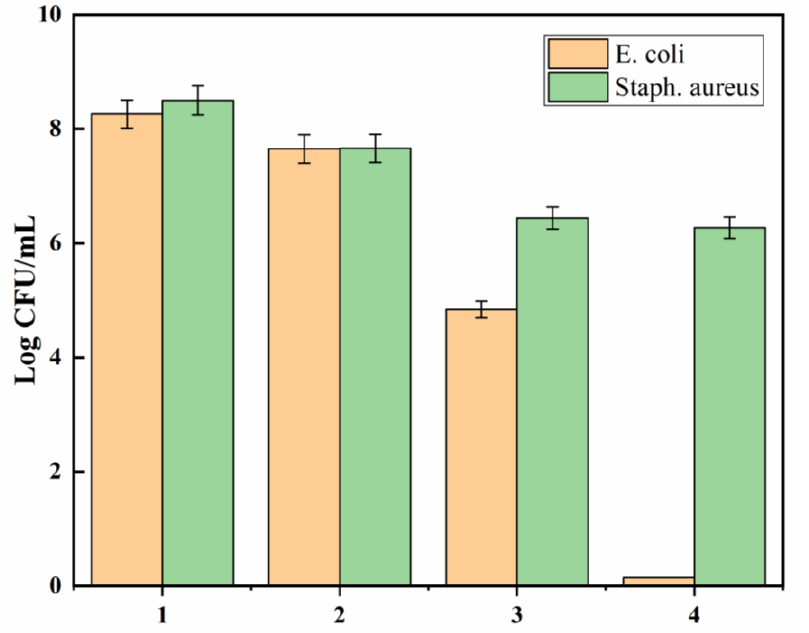
Figure 9. Effect of the (1) PET, (2) PET hydrazide, (3) PET hydrazide-AgNP-PDA, and (4) PET hydrazide-AgNP on the microbial growth of E. coli and Staphylococcus aureus , after incubating for 24 h at 37 °C.